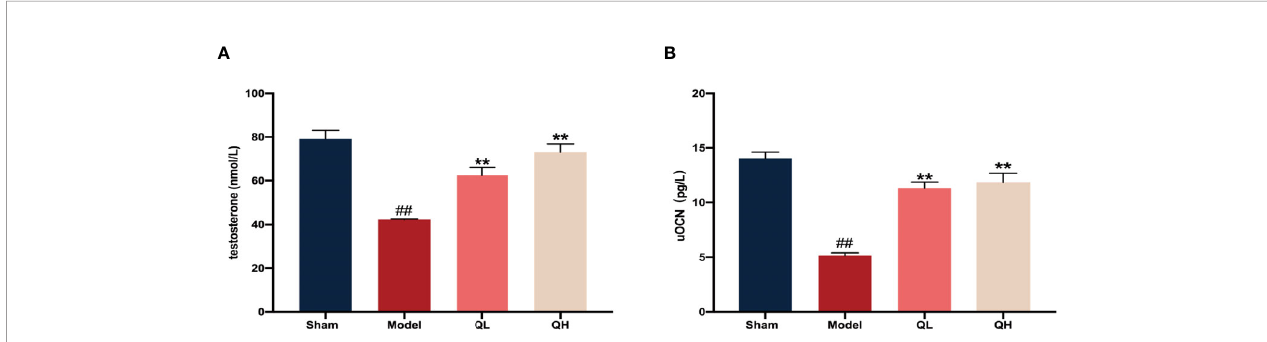
FIGURE 1 | Changes in serum levels of testosterone and undercarboxylated osteocalcin (uOCN) in mice that have undergone orchiectomy. (A) Serum testosterone levels in the sham-operated (sham), model (model), low- (QL), and high-quercetin groups (QH). (B) Serum uOCN levels in all treatment and control groups. ## p< 0.01 vs. sham group; ** p< 0.01 vs. model